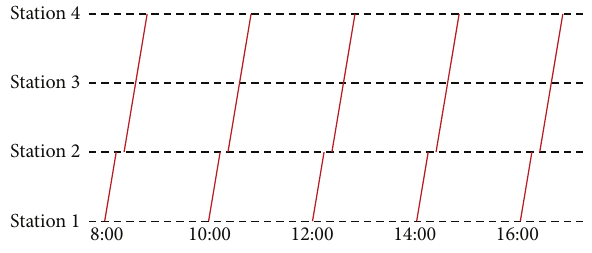
Figure 1: Periodic operation of trains of a type.